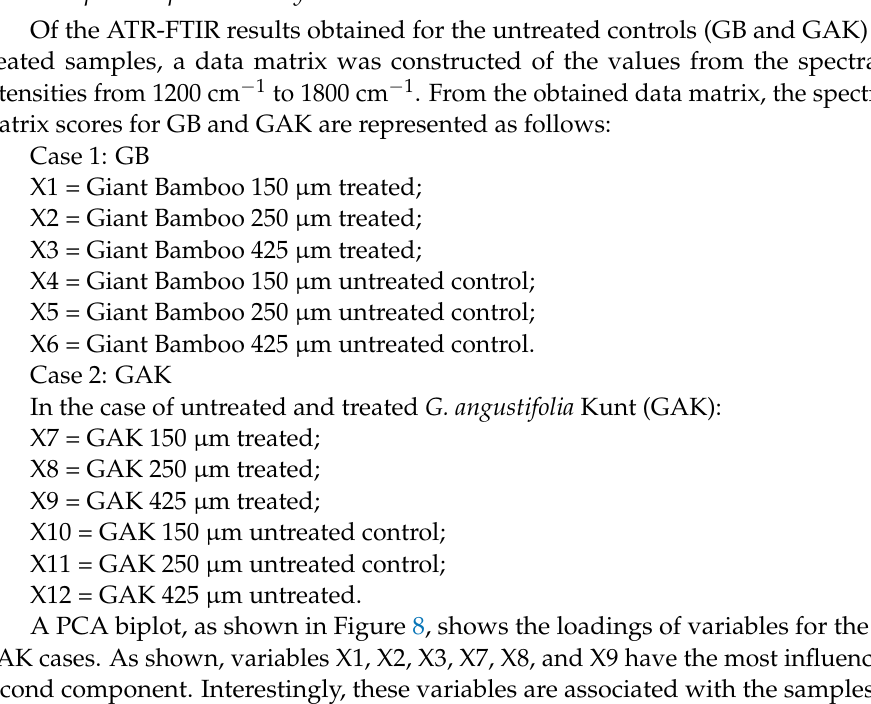
Figure 7. Comparison of the ATR-FTIR spectra at a range of 1800 cm − 1 to 1200 cm − 1 for the ( a ) treated GB and control and ( b ) treated GAK and control samples. A correction baseline was performed. Of the ATR-FTIR results obtained for the untreated controls (GB and GAK) and the treated samples, a data matrix was constructed of the values from the spectral range in-